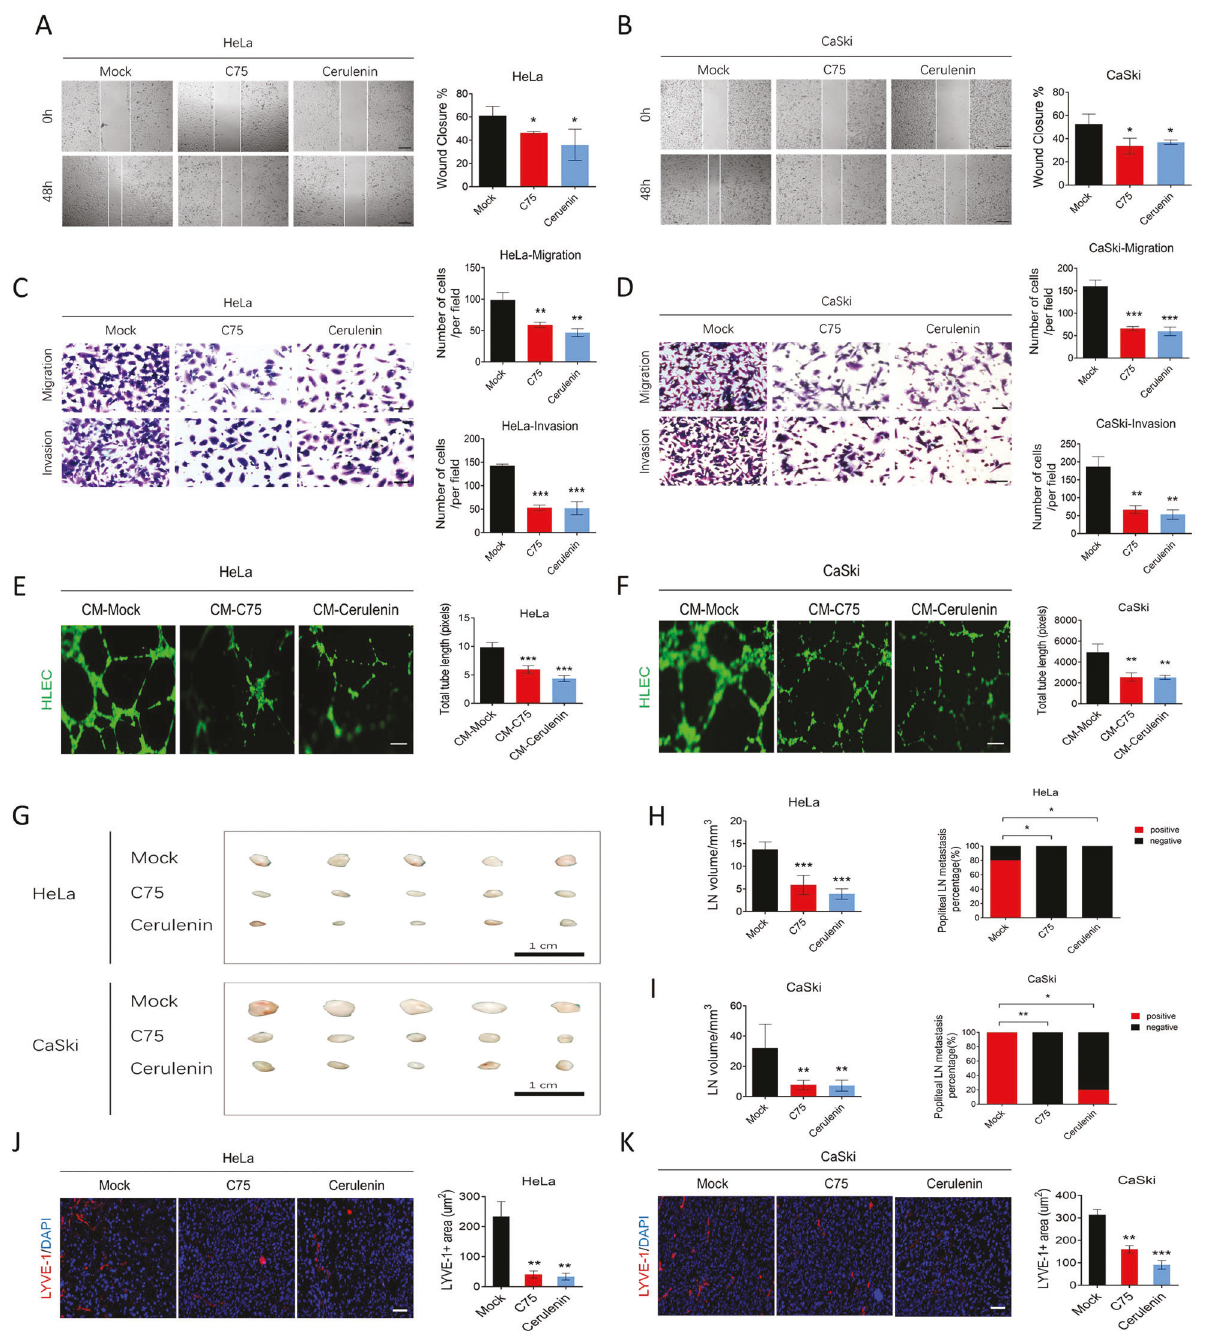
Fig. 7 FASN inhibitors suppress cervical cancer cell migration, invasion, lymphangiogenesis in vitro, and lymph node metastasis in vivo. A , B The wound healing assay results in the mock-, C75-, and Cerulenin-treated HeLa and CaSki cells. Bar = 200 µm. C , D Transwell migration and invasion results in the same settings as A , B . Bar = 50 µm. E , F Assessment of lymphangiogenesis by tube formation assays in the CM-mock (mock vehicle-treated tumor culture medium) and CM-C75 or CM-Cerulenin (C75- or Cerulenin-treated tumor culture medium) groups and the total tube length. Bar = 100 µm. G A gross popliteal lymph node specimen is shown. Bar = 1 cm. H , I LN volume and metastasis percentage were quanti fi ed in the mock, C75, and Cerulenin groups using both cell lines injected into the CC lymph node mouse model. J , K